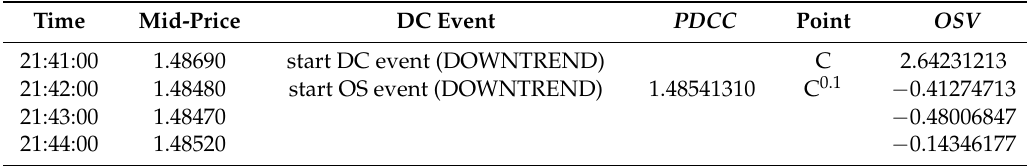
Figure 6. Illustration of DC summary with theta = 0.1%. [AA 0.1 ] denotes a downward DC event. The point marked with a red “x” denotes the time at which IDBA triggers a buy order ( Rule DBA.1 ). TBO denotes the time length between the time at which the DC event [AA 0.1 ] starts (i.e., the extreme point “A”) and point “x”. Table 3. An example of a DC summary of GBP/CHF mid-prices sampled minute-by-minute on 1 January 2013 from 21:41:00 to 22:01:00 (UK time). Excessive and unnecessary observation were omitted. theta = 0.10%. We also compute the values of PDCC and OSV